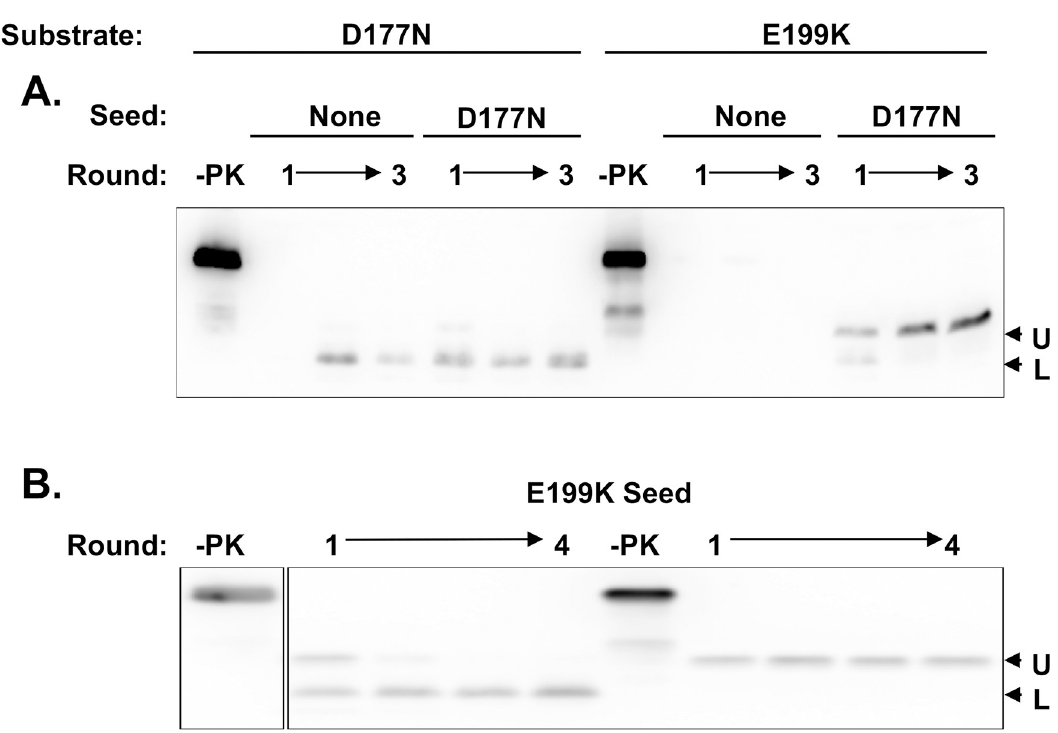
Fig 5. Shaking-induced mutant recPrP Sc molecules. Western blots showing serially propagated shaking conversion reactions using D177N (left) and E199K (right) mutant Mo recPrP substrates. Reactions were initially seeded with (A) buffer (none), PMCA- generated D177N Mo PrP Sc , or (B) shaking-generated E199K Mo PrP Sc , as indicated. (-PK) = sample not subjected to proteinase K digestion; all other samples were proteolyzed. U = Upper MW band (~16 kDa); L = Lower MW band (~10 kDa).